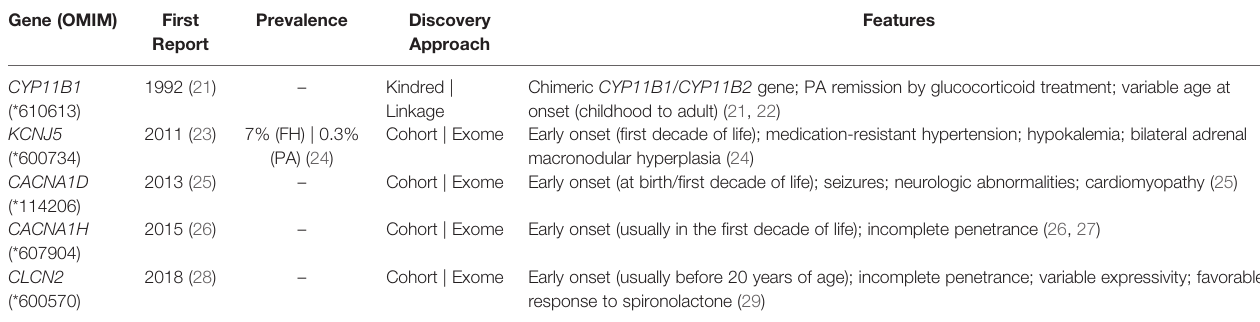
TABLE 1 | Genetic causes of familial